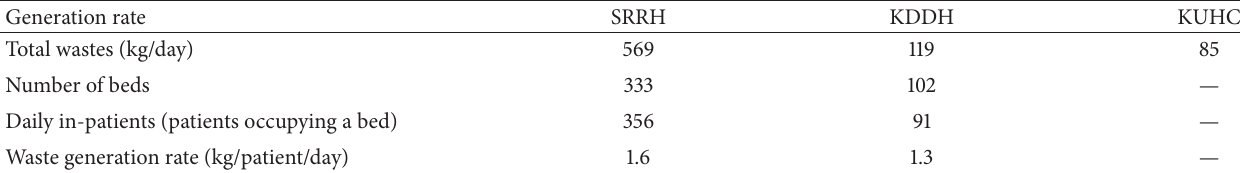
Table 4: Summary of healthcare waste generation rates for SRRH, KDDH, and